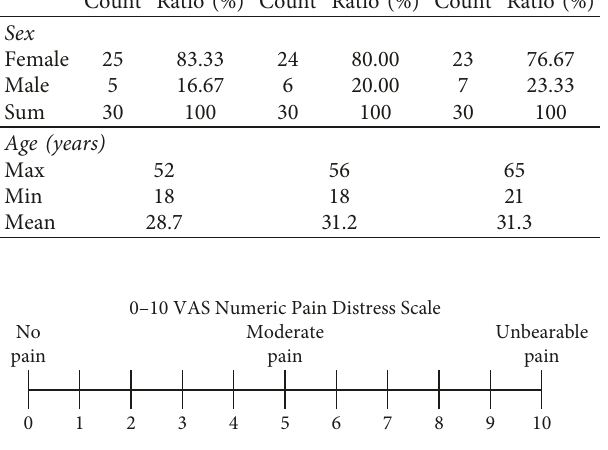
Table 1: Group characteristics according to sex, age, and gender. Control